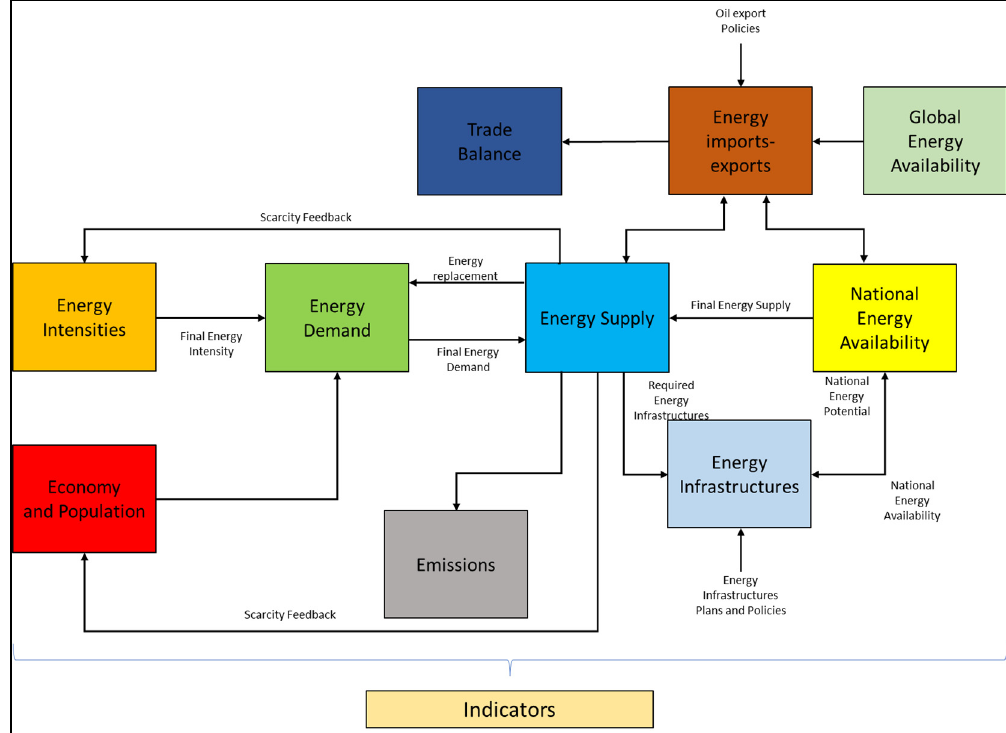
Figure 1. Schematic overview of EEDEC model [53].